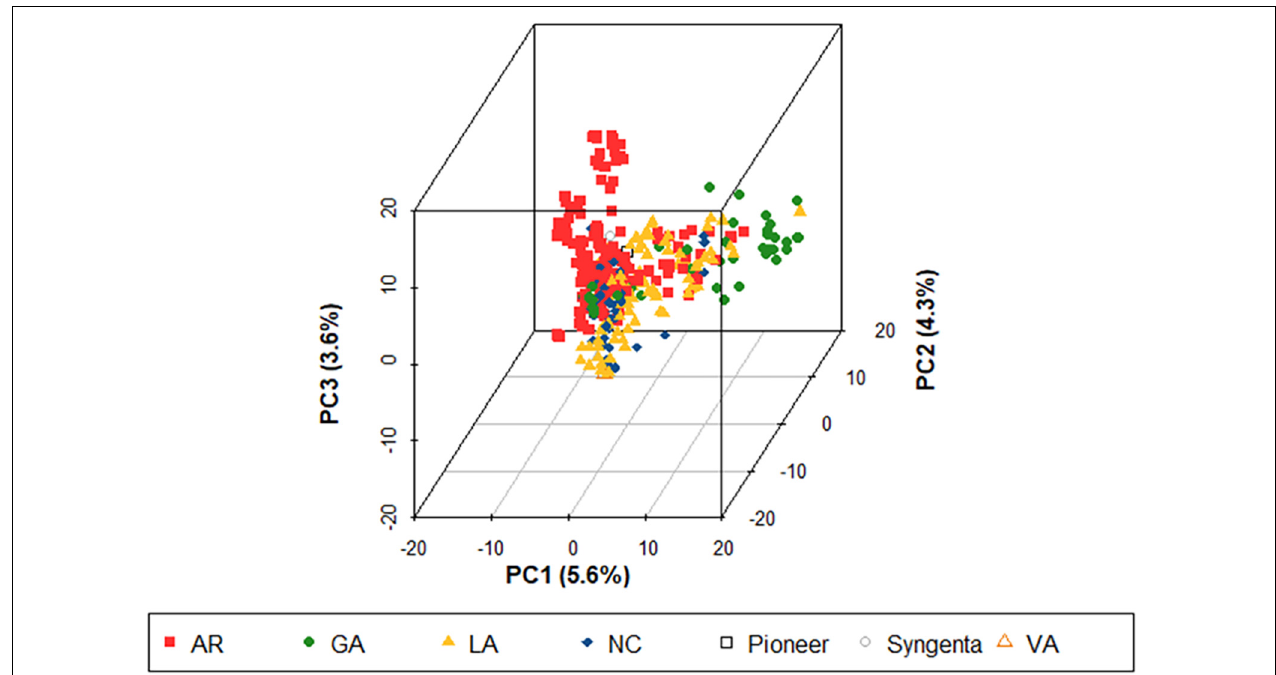
FIGURE 1 | Population structure of 355 soft red winter wheat genotypes using 5,202 single nucleotide polymorphism (SNP) markers. This population represents the training population used to predict three Fusarium head blight (FHB) resistance traits including deoxynivalenol (DON) concentration, Fusarium damaged kernels (FDK), and severity (SEV) (TP18_FHB) for the 2018 advanced Fusarium head blight trial (ADV18). Colors represent the origin of the genotypes. AR, developed at the University of Arkansas, Fayetteville; GA, developed at the University of Georgia, Athens; LA, developed at Louisiana State University, Baton Rouge; NC, developed at North Carolina State University, Raleigh; Pioneer, developed by Pioneer Hi-Bred International; Syngenta, developed by Syngenta and AgriPro; and VA, developed by Virginia Polytechnic Institute and State University, Blacksburg; PC, principal